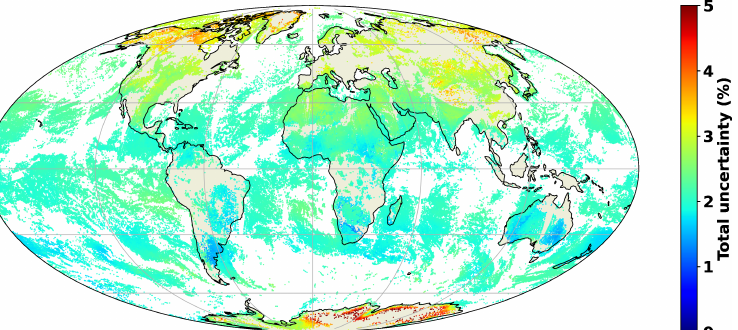
Figure 14. Example of N 2 O partial column total uncertainty due to vertical smoothing, spectral noise, water vapor and temperature profiles, for 15 December 2018.